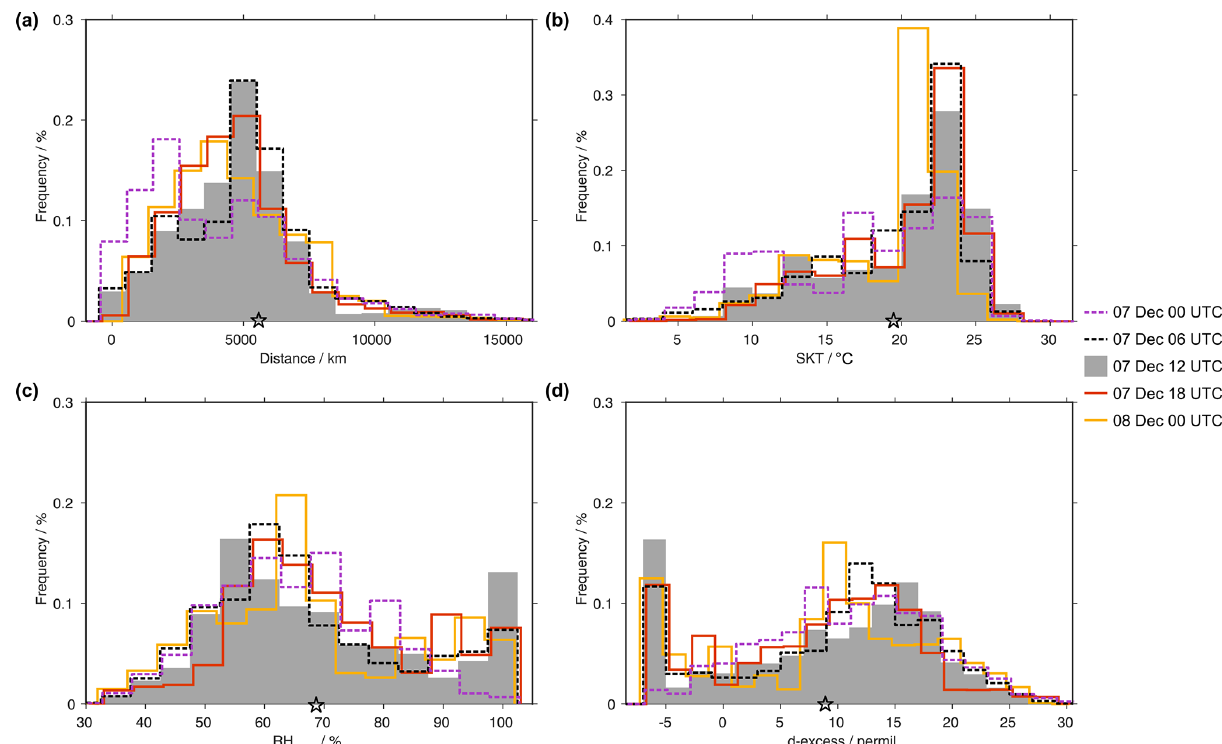
Figure 8. Histograms of moisture source conditions identified with the Lagrangian moisture source diagnostics from 20d backward trajec- tories during the AR event in southwestern Norway. (a) Moisture source distance (km), (b) moisture source temperature ( ◦ C), (c) moisture source relative humidity with respect to sea surface temperature (RH SST ), and (d) d -excess estimated from the empirical relation of Pfahl and Sodemann (2014). Grey filled bars show the most intense period of the event (Phase III, 07 December 2016 at 12:00UTC), dotted lines the 12h before (Stage I and II), and solid lines the 12h after the central period (Stage IV). Histograms represent the normalized contributions of each moisture source location to the precipitation at the arrival region on the respective date. The star symbol indicates the mean value of the distribution at 12:00UTC on 7 December